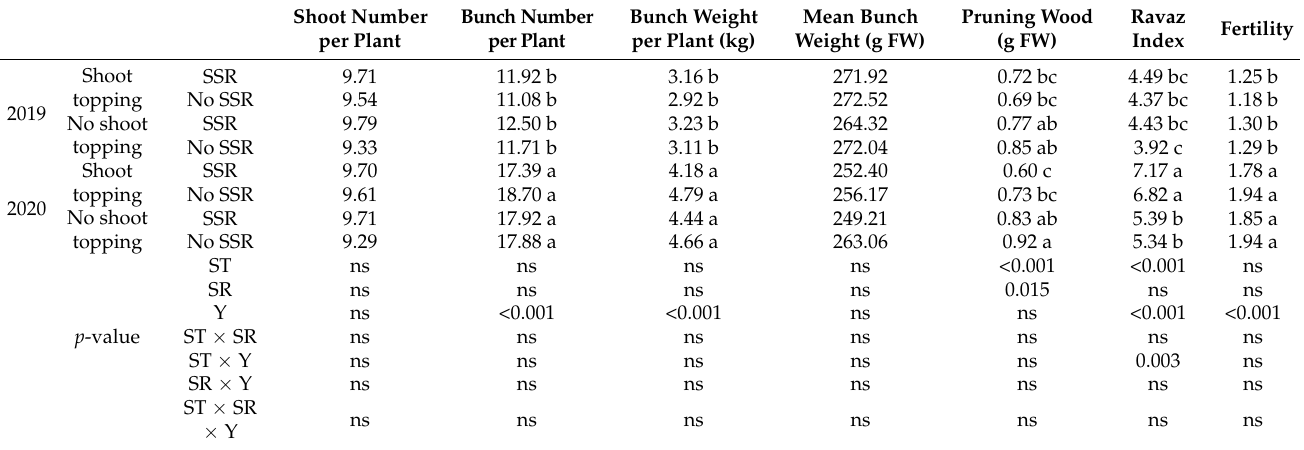
Table 1. Effect of shoot topping application and secondary removal on shoot number per plant, bunch number per plant, bunch weight per plant, mean bunch weight, pruning wood, Ravaz index, and fertility collected in 2019 and 2020. Data are means (n = 24). Data were analyzed with three-way ANOVA to assess interactions between years (ST—shoot topping factor; SR—secondary removal factor; Y—Year). p -value is shown in the text while ns express non-significant differences ( p > 0.05). Different letters represent significant differences between treatments according to Tukey’s test.